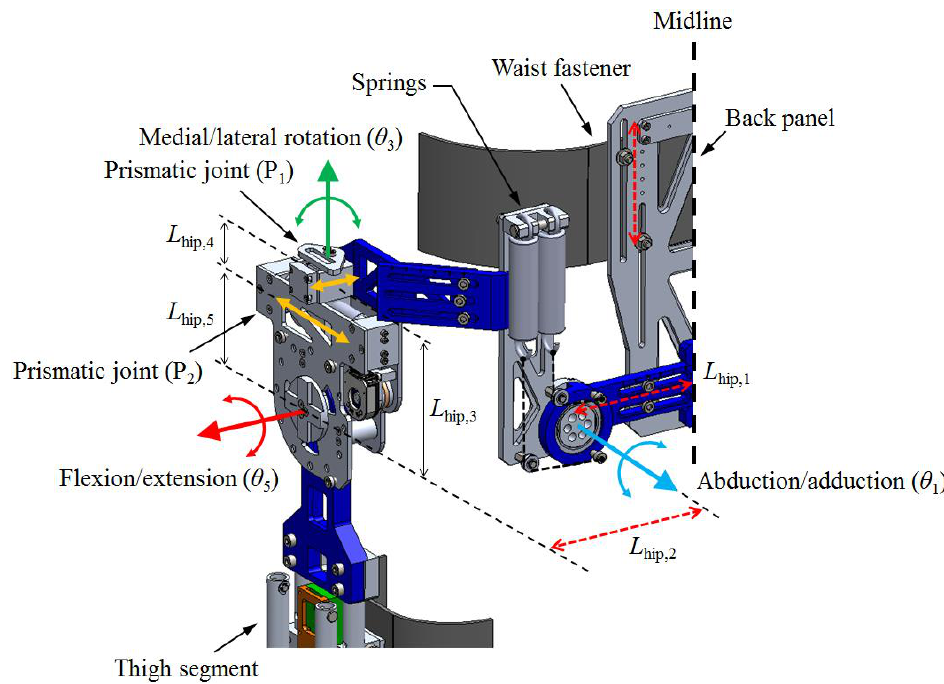
Figure 2. Hip joint structure for hip flexion/extension, abduction/adduction, and medial/lateral rotation.